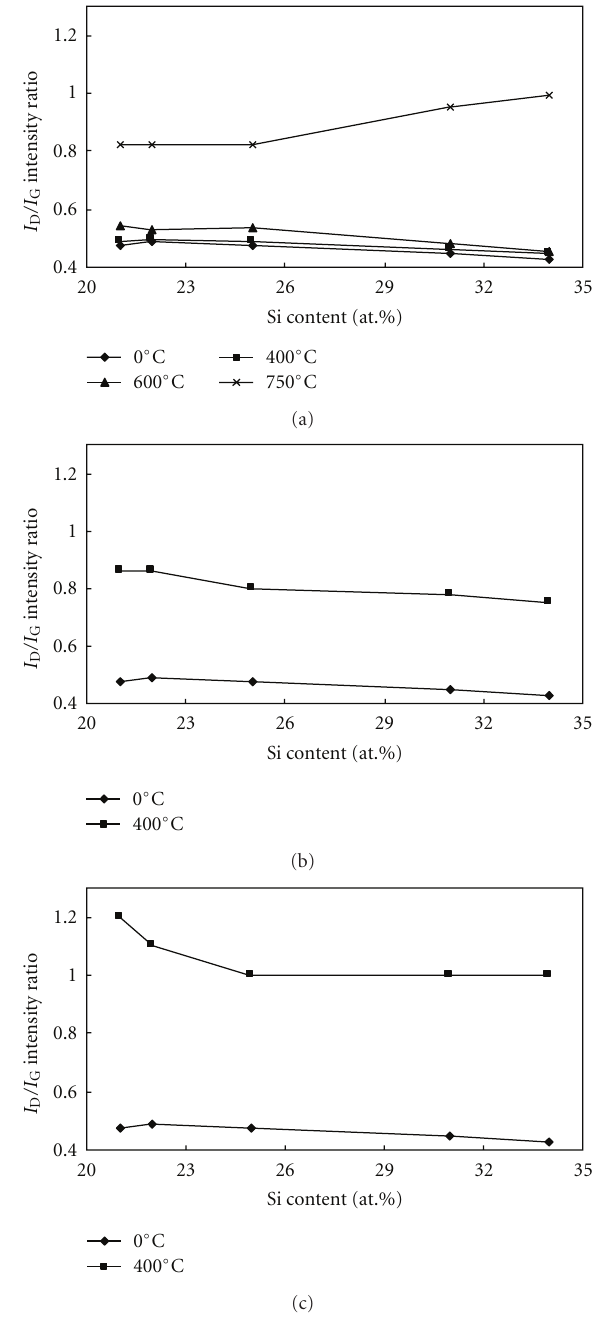
Figure 3: I D /I G intensity ratio of DLC-Si–O films before and after annealing at various temperatures in (a) vacuum, (b) argon, (c) air.